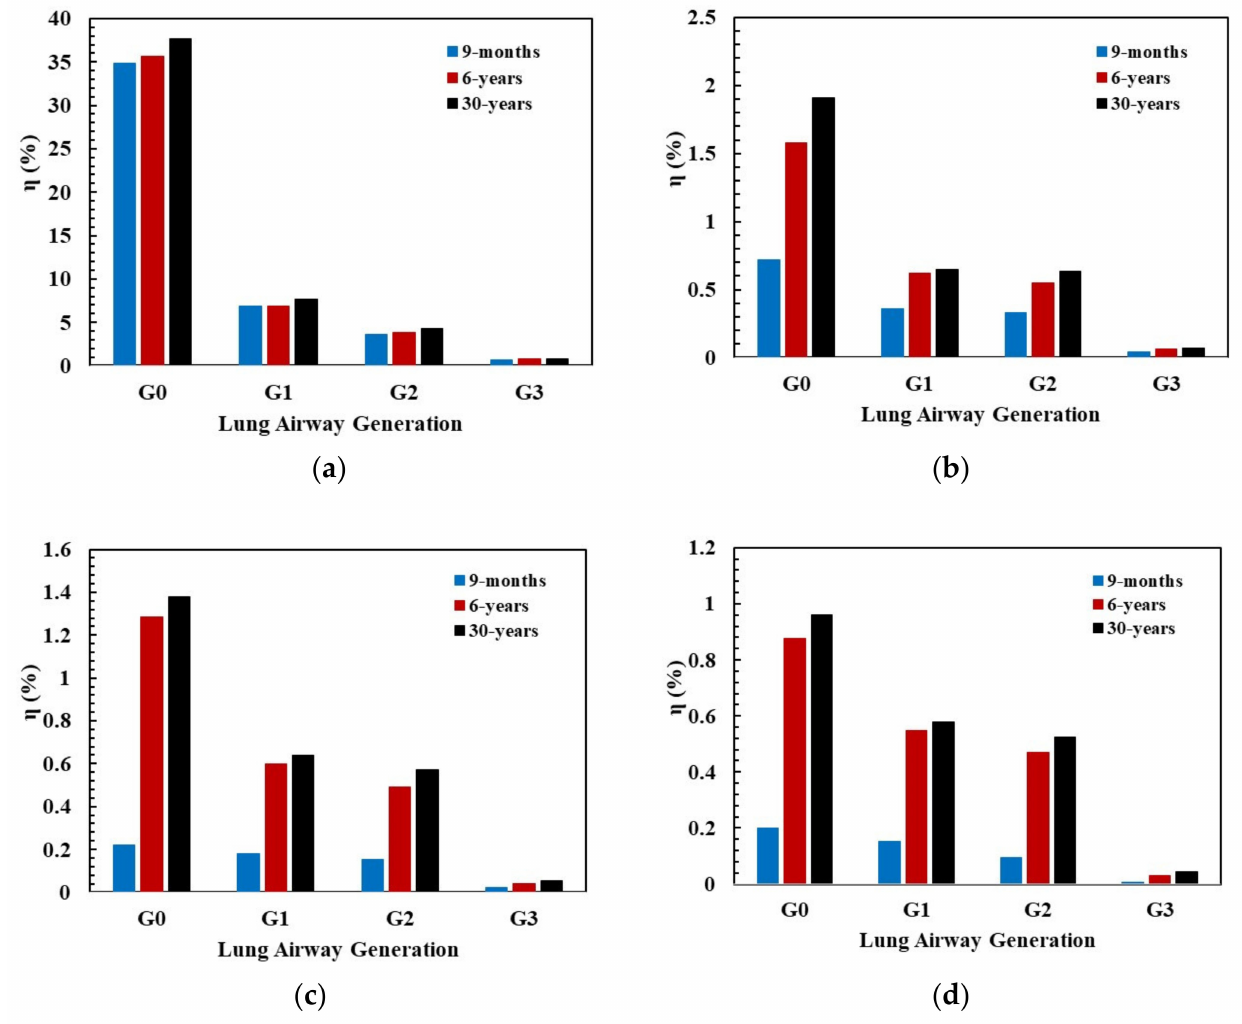
Figure 10. Different size particle deposition efficiencies at upper airways generation (G0–G3) of the lung are defined in Figure 1. ( a ) d p = 5 nm, ( b ) d p = 50 nm, ( c ) d p = 100 nm, and ( d ) d p = 500